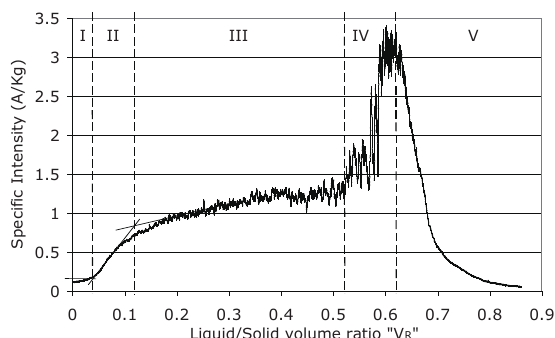
Fig. 1a Intensity consumption of the calcite 1 mixed with a progressive water addition (40 ml/min; 120 rpm) and schematic wetting regime states ( pendular II , funicular III , capillary IV